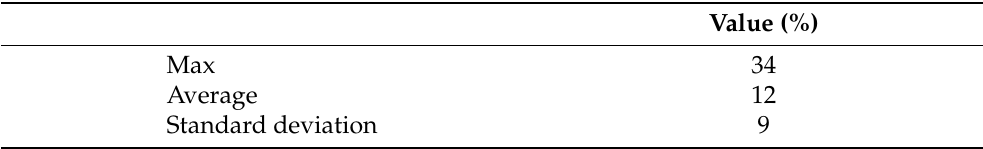
Table 7. Producers yield benefits from optimized